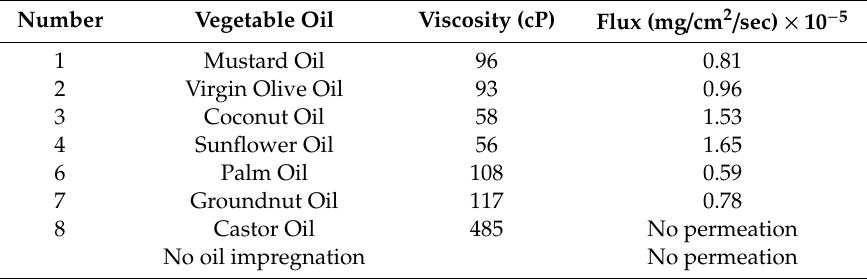
Table 2. Selected vegetable oils along with their viscosity and flux.